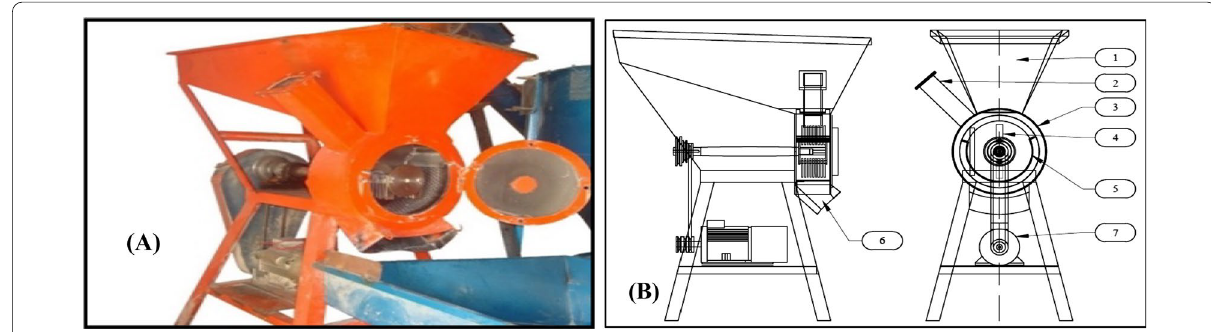
Fig. 2 The local hammermill: A Hammermill in the farm, B the components of hammermill before developing (1—main hopper, 2—inlet hole, 3— milling room, 4—hammers, 5—screen, 6—outlet hole, 7—electric motor)